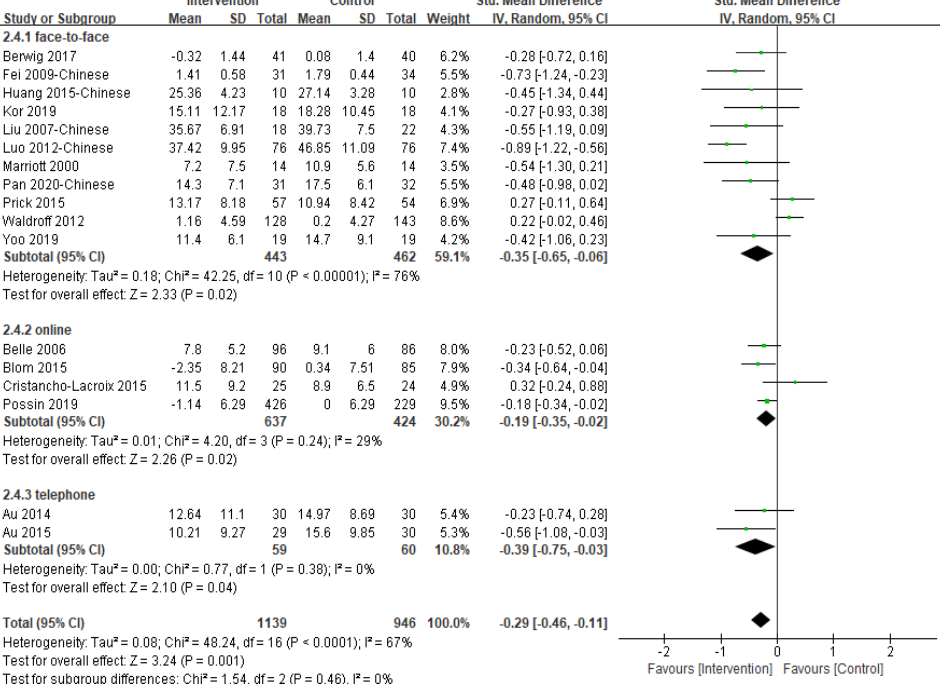
Figure 4. Effect of multi- component interventions on informal caregiver’s depression (post -inter-vention).